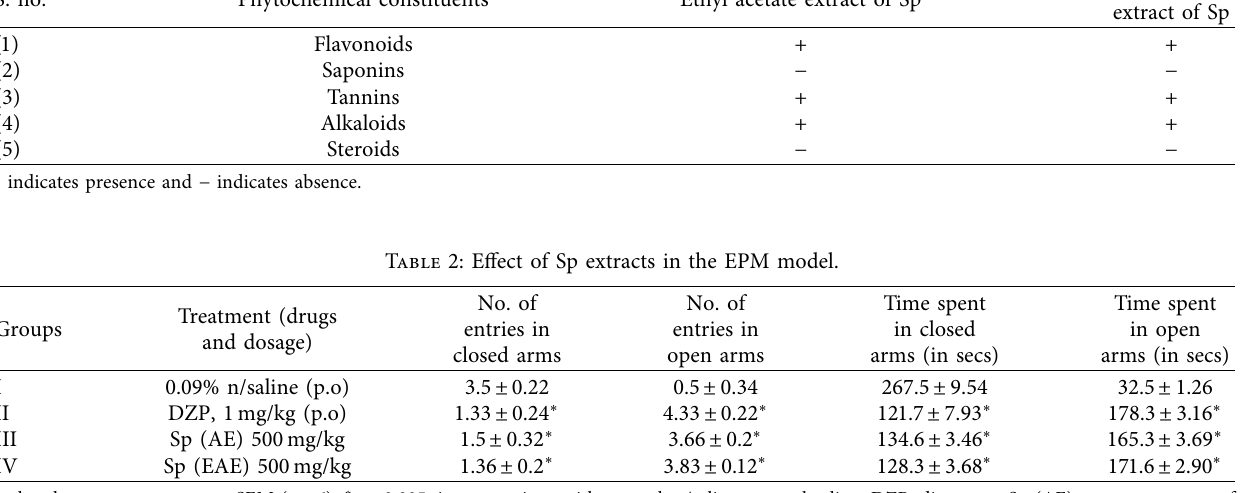
Table 1: Preliminary qualitative test of stem barks of Salvadora persica (Sp) extracts. S. no.